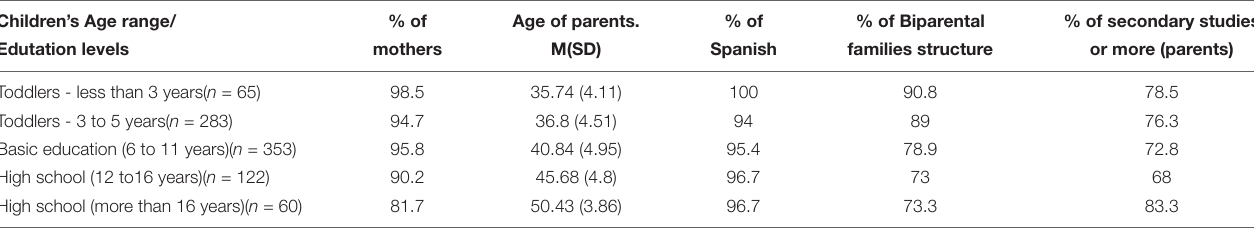
TABLE 1 | Sociodemographic data of sample ( N = 883). Children’s Age range/ % of Age of parents. %